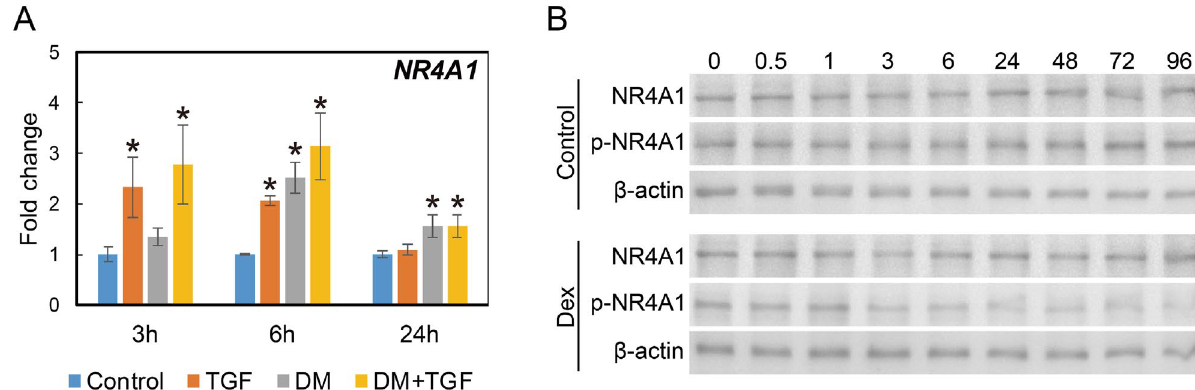
Figure 6. NR4A1 expression and phosphorylation in Dexamethasone-treated vocal fold fibroblasts. HVOX cells were treated with TGF-β1 (TGF-β; 10 ng/mL) and dexamethasone (DM; 10 −7 M) for 3, 6, and 24 h. NR4A1 mRNA expression was examined by qPCR ( A ). Relative expression levels of each gene to GAPDH were compared with those of the control group, and are shown as mean ± SEM (n = 3). * P < 0.05 vs. control. ǂ P < 0.05 vs. TGF-β. HVOX cells were treated with dexamethasone for 0, 0.5, 1, 3, 6, 24, 48, 72 and 96 h and Western blot was performed using antibodies against NR4A1 and phosphorylated NR4A1 (p-NR4A1) ( B